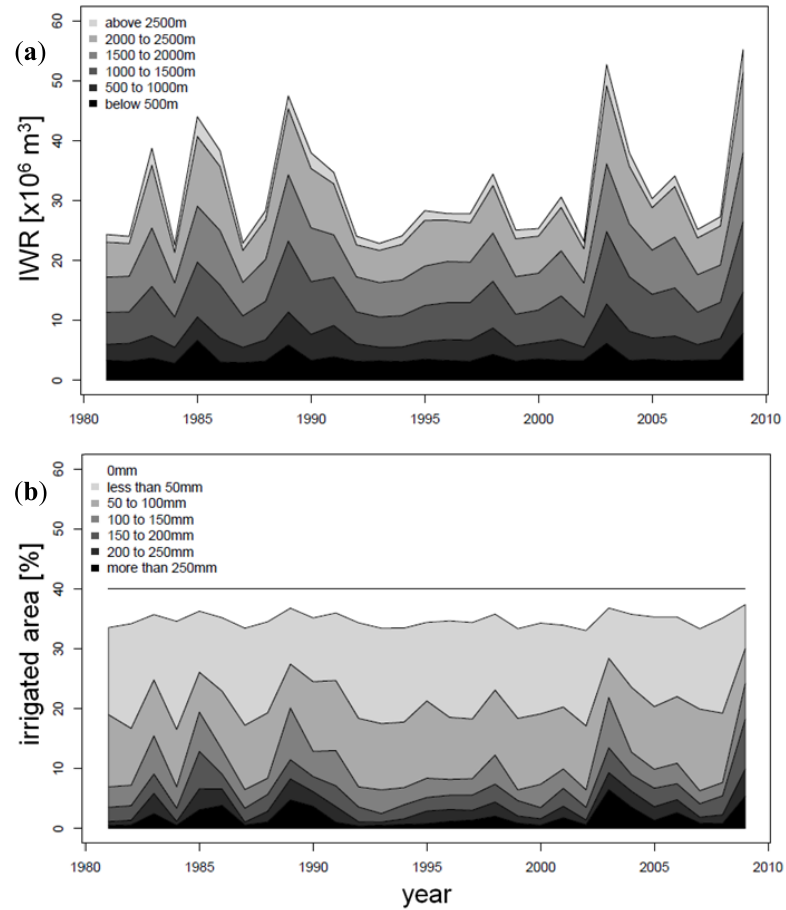
Figure 6. Stacked area charts of ( a ) total IWR during 1981–2009 for different elevation ranges; and ( b ) of the percentage of the total agricultural area that required different irrigation intensities. The 41% line indicates the potentially irrigated